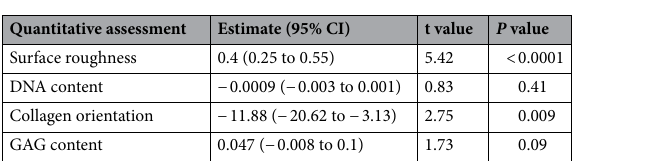
Table 2. Multiple linear regression analysis of quantitative assessment values and total histological